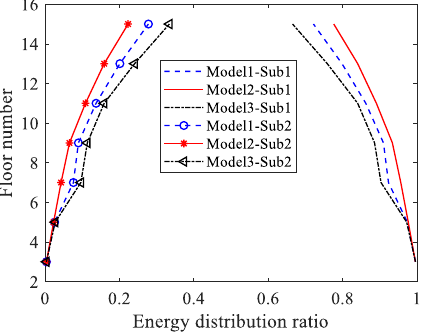
Figure 11. The energy proportion of the two substructures.